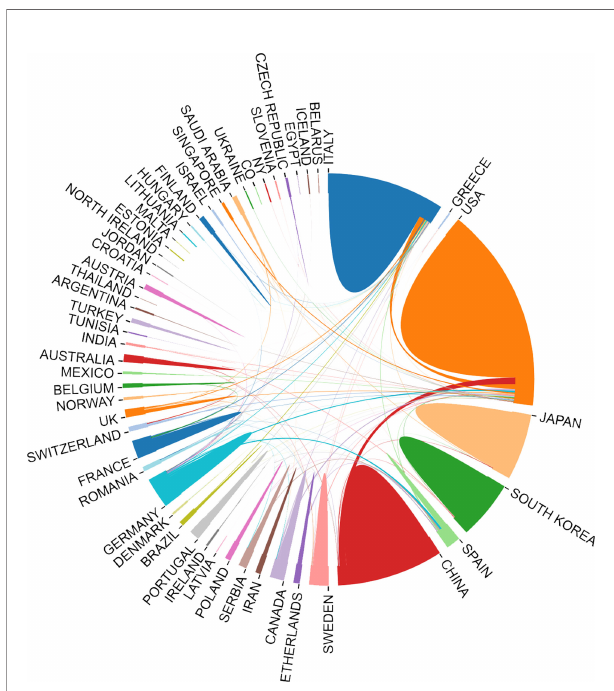
FIGURE 4 | Cooperation pattern among contributed countries in ATC fi